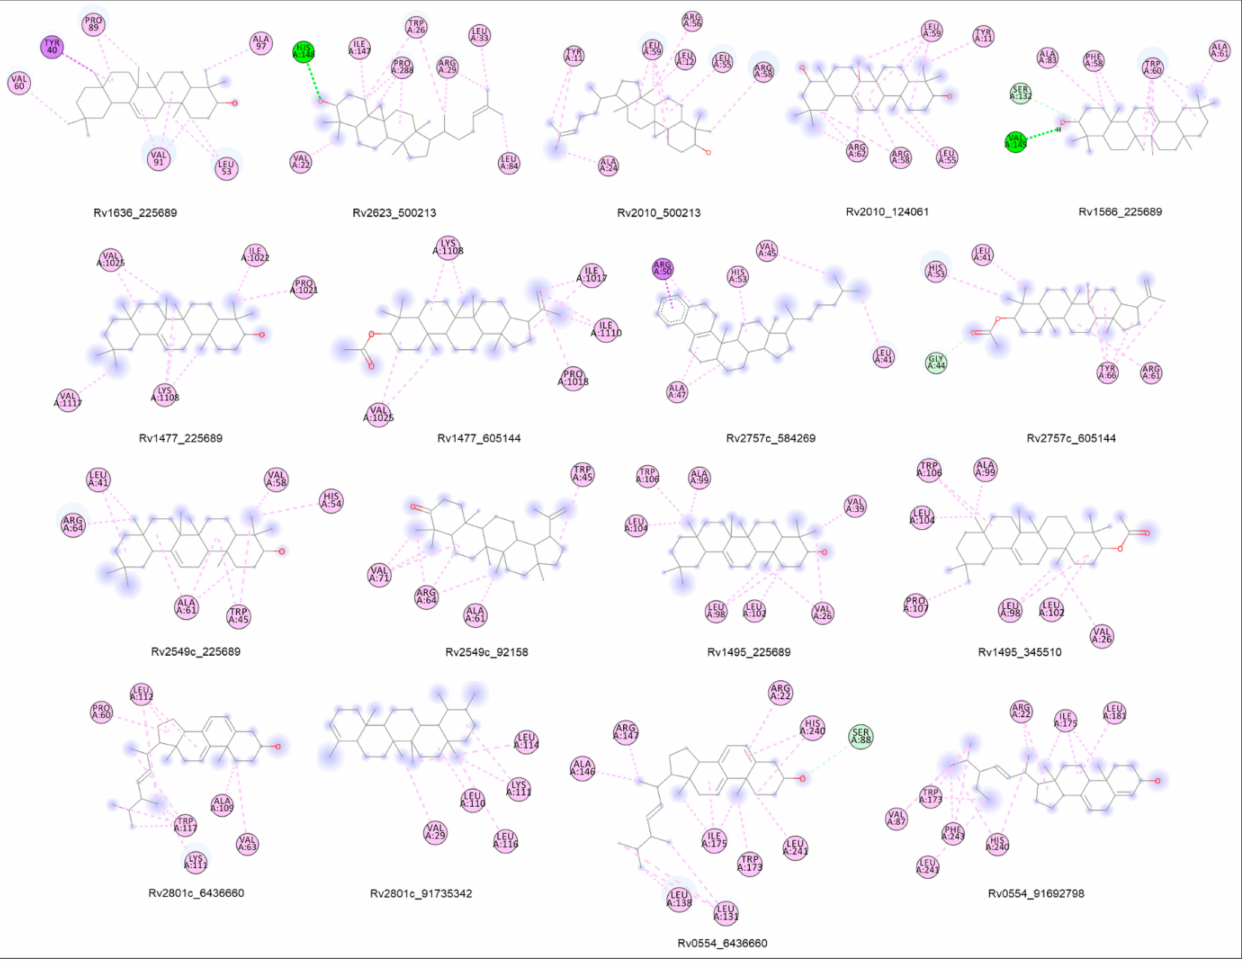
Figure 8. Docking interaction analysis: 2D structural representation of Protein-ligand complexes having pi-Alkyl bonds (purple) and Hydrogen bond (green) along with interacted